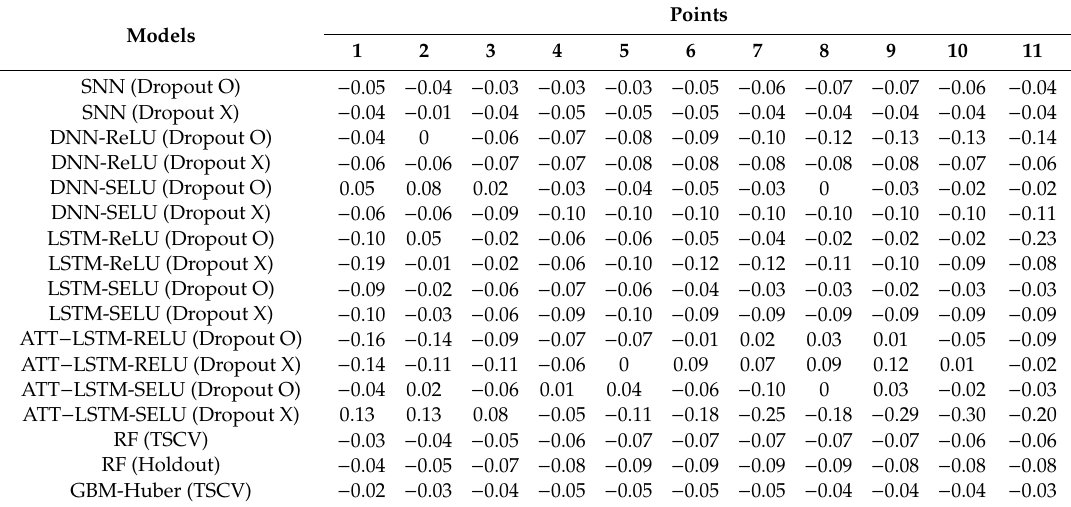
Table 5. Mean bias error (MBE) distribution for each model for Ildo-1 (MJ/m 2 ).